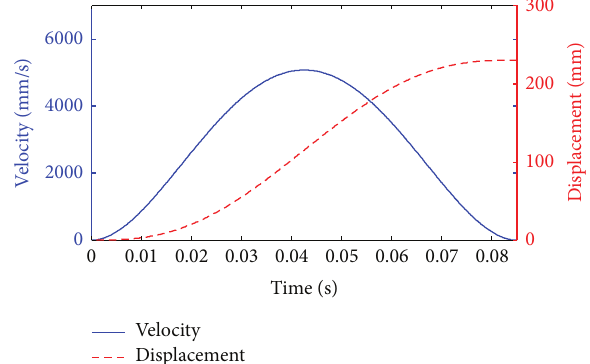
Figure 12: Characteristics of the input displacement and velocity